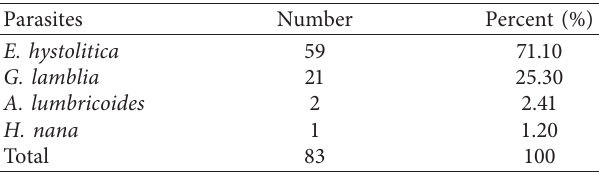
Table 3: Prevalence of intestinal parasitic infections among school- age children in Kutaber district, Northeast Ethiopia, 2019 ( n �